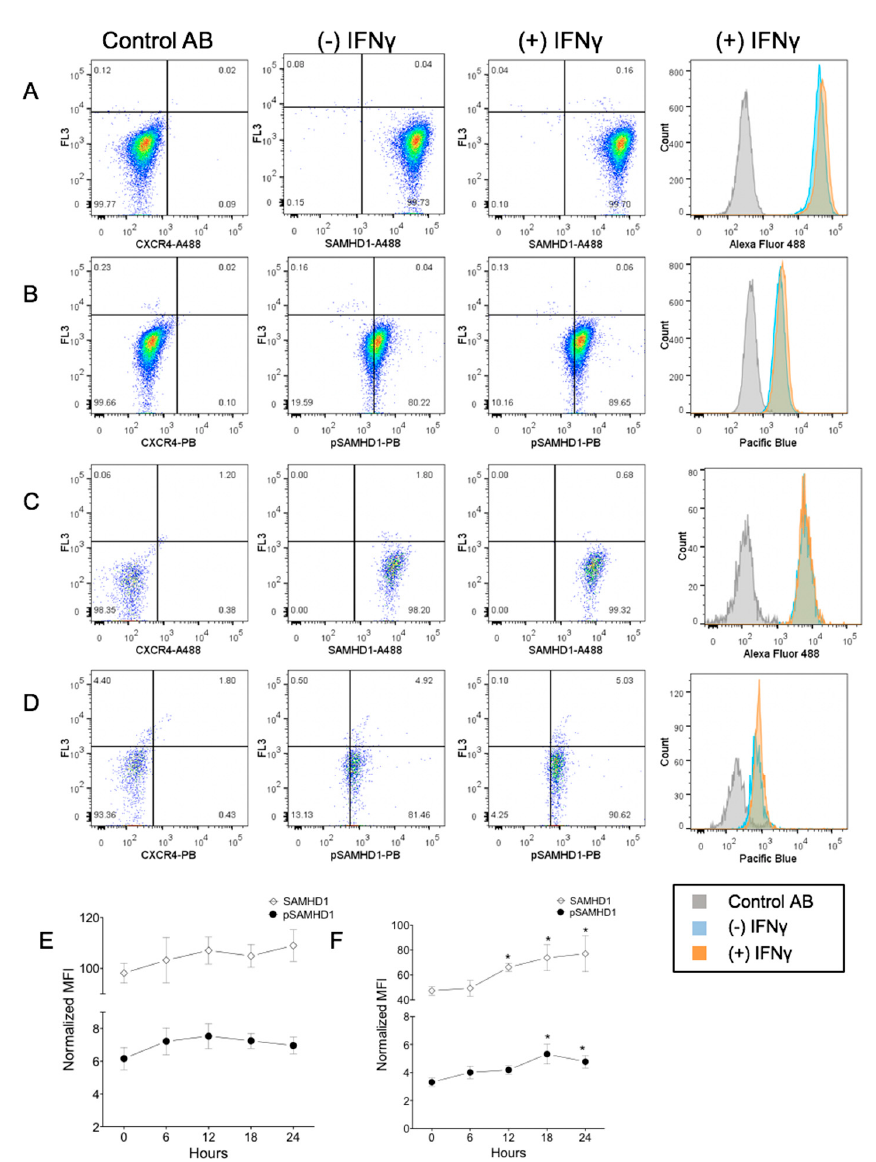
Figure 3. Flow cytometric assessment of a subcellular localization of total and phosphorylated SAMHD1. Whole cells ( A , B ) or nuclei ( C , D ) were stained with a fluorochrome-labeled non-binding CXCR4 antibody as the negative control, and with anti-SAMHD1 or anti-pSAMHD 6 h after treatment with 1.2 ng / mL of IFN γ . Both whole cells and nuclei were positive for SAMHD1 and pSAMHD1, but a significant increase in fluorescence associated with IFN γ treatment was noted only for the nuclear pSAMHD1 ( D ). Analysis over time showed that neither whole cell ( E ) SAMHD1 or pSAMHD1 increased significantly, but that nuclear ( F ) SAMHD1 and pSAMHD1 were significantly higher in treated cells at 12, 18 and 24 h, and at 18 and 24 h, respectively (*). 3.4. IFN α Treatment Does Not Significantly Change SAMHD1 Phosphorylation or Localization Flow cytometric analysis revealed that treatment of cells for 6 h with 1000 U / mL of IFN α did not significantly change SAMHD1 localization or phosphorylation in either whole cells or nuclei (Figure 4). Similarly, assessment over time did not reveal significant